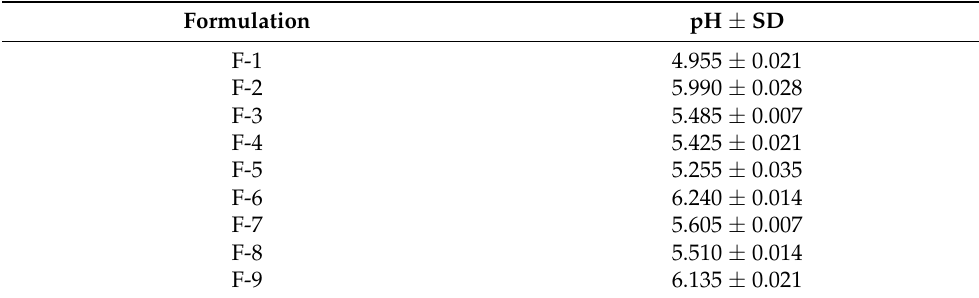
Table 2. pH values of obtained hydrogel base, ACTH formulations and ACTH with albumin formulations, ( n =